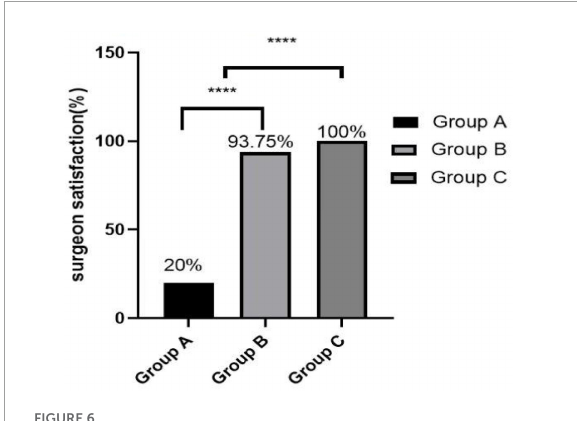
FIGURE6 Surgeon satisfaction. ****Group A vs. Group B, P < 0.001 and Group A vs. Group C, P < 0.001.